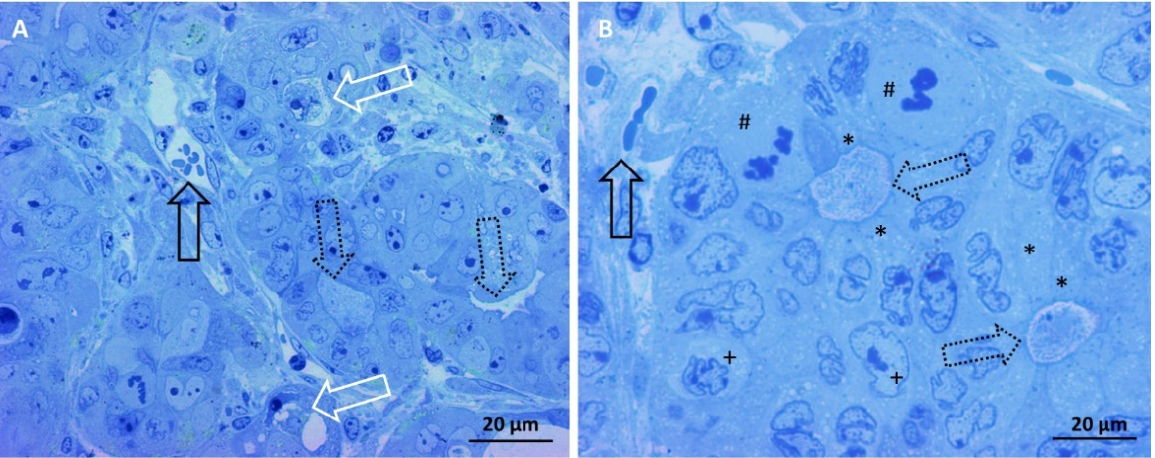
Figure 5. Xenograft tissue organization is illustrated by LM, magnification 400×. ( A ) The xenograft tissue consists of pseudocyst structures (black dotted arrows) arranged into a scarce stroma. The tissue is vascularized (black arrow), but hypoxic and necrotic areas are visible (white arrows). ( B ) Cells with columnar shape, similar to enterocytes (*), line pseudocyst lumen. Round cells with large oval and/or indented nuclei (+) do not reach the gland lumen. Mitotic figures (#) are observed, and blood vessels are shown (black arrow).